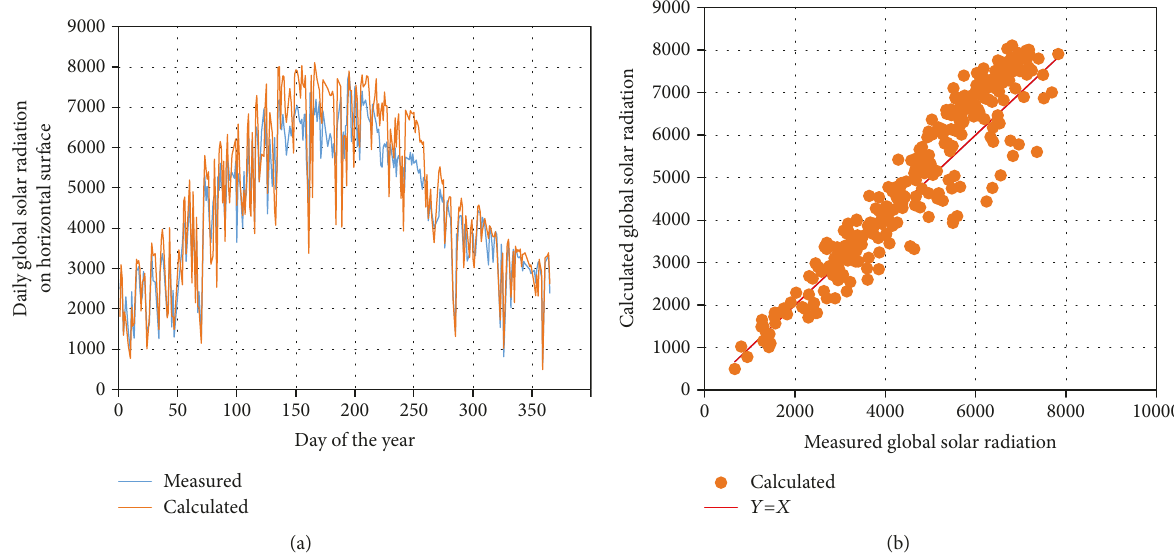
Figure 1: Comparison between measured and estimated values of global radiation.